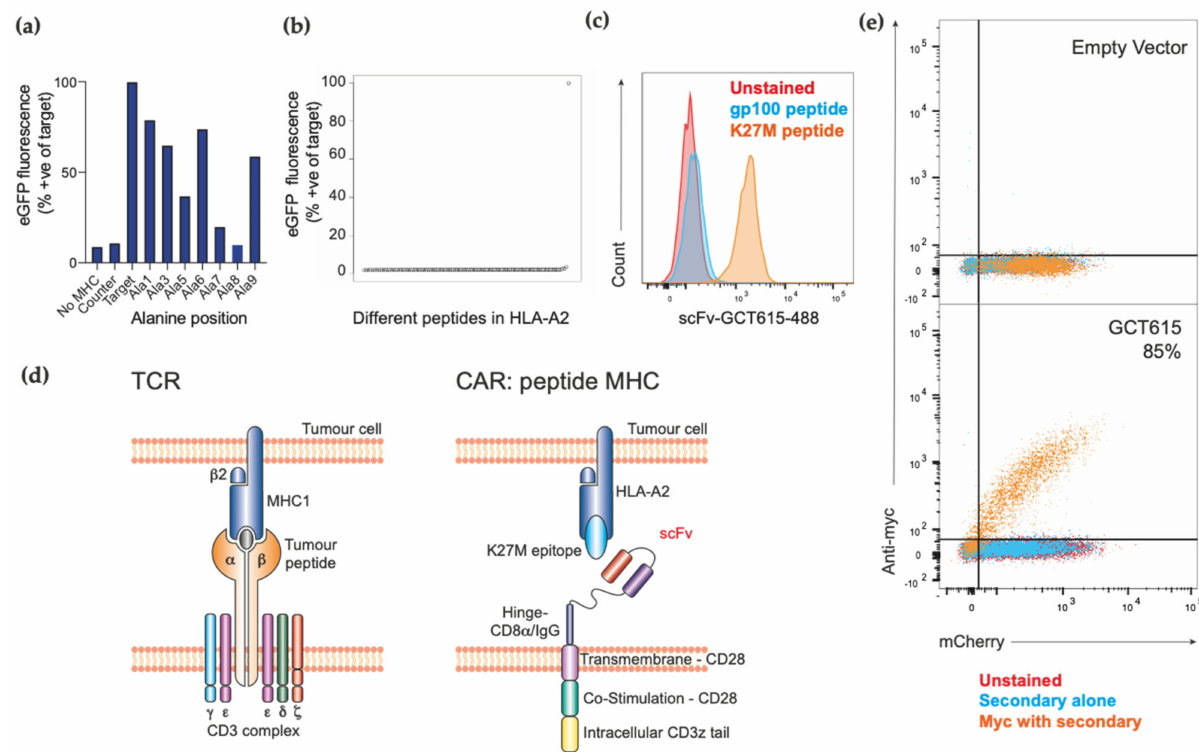
Figure 1. Generation of H3.3-K27M-specific CAR T cells. ( a ) Binding of GCT615 to H3.3K27M-HLA-A*02:01, and to related HLA complexes composed of alanine-substituted peptide epitopes. Demonstrates loss of GCT615 binding when alanine is substituted at position 7 or 8 of the peptide. ( b ) Binding of GCT615 to a native HLA-A*02:01 peptide panel known to be presented at the cell surface (specificity panel). No significant binding to off-target complexes is observed. First data point corresponds to negative control lacking scFv; right-most data point is positive control binding to target H3.3K27M-HLA-A*02:01complex. ( c ) Flow cytometry histogram displaying monomeric GCT615 scFv-488 binding to the HLA-A2.H3.3K27M peptide-MHC complex of T2 cells, either unlabelled (red), or pulsed H3.3-K27M peptide (orange), or the negative control gp100 peptide (blue). ( d ) A schematic diagram of a TCR versus a CAR targeting peptide:MHC complex; ( e ) Flow cytometry labelling of primary murine T cells transduced with either mCherry alone empty vector CAR (top panel), or the GCT615-CAR (bottom panel), showing transduction efficiency of the CAR as determined by mCherry and labelled with anti-myc antibody (Clone 9B11, Cell Signaling, Danvers, MA, USA), with secondary anti-mouse IgG AF488 (goat polyclonal, ab150117,